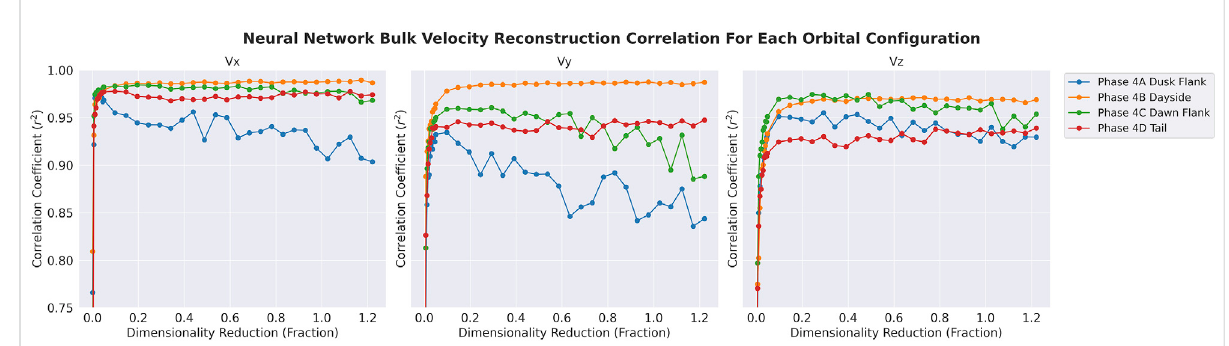
FIGURE 2 The correlation coef fi cient r 2 performance of the bulk velocity components V x , V y , V z (GSE) on a per-orbital-con fi guration basis. The independentvariableonthe y -axisinthedimensionalityreductionfraction(DRF)correspondstothesizeofthelatentrepresentationsforeachpatch. In this plot, we observe a knee in the performance curve occurring at DRF ’ s between .05 and .10, corresponding to a dimensionality reduction between 10 and 20. Other characteristics of the performance, such as the dependence on orbital con fi guration and bulk velocity component, as well as the low performance as the DRF before the knee, are discussed in the text. DRFs above one corresponds to networks that do not actually perform dimensionality reduction and instead demonstrates information loss not associated with a reduced number of